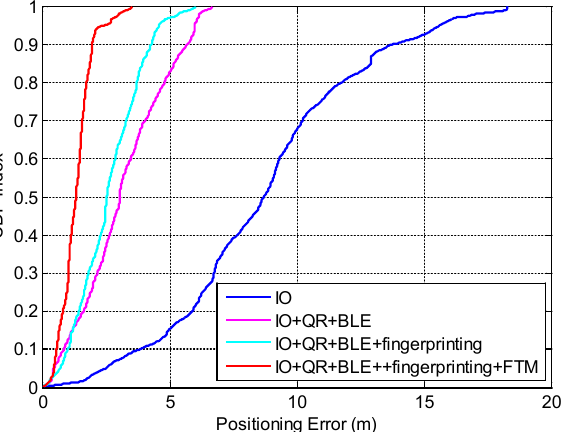
Figure 16. Estimated CDF errors using inertial odometry and RUKF.